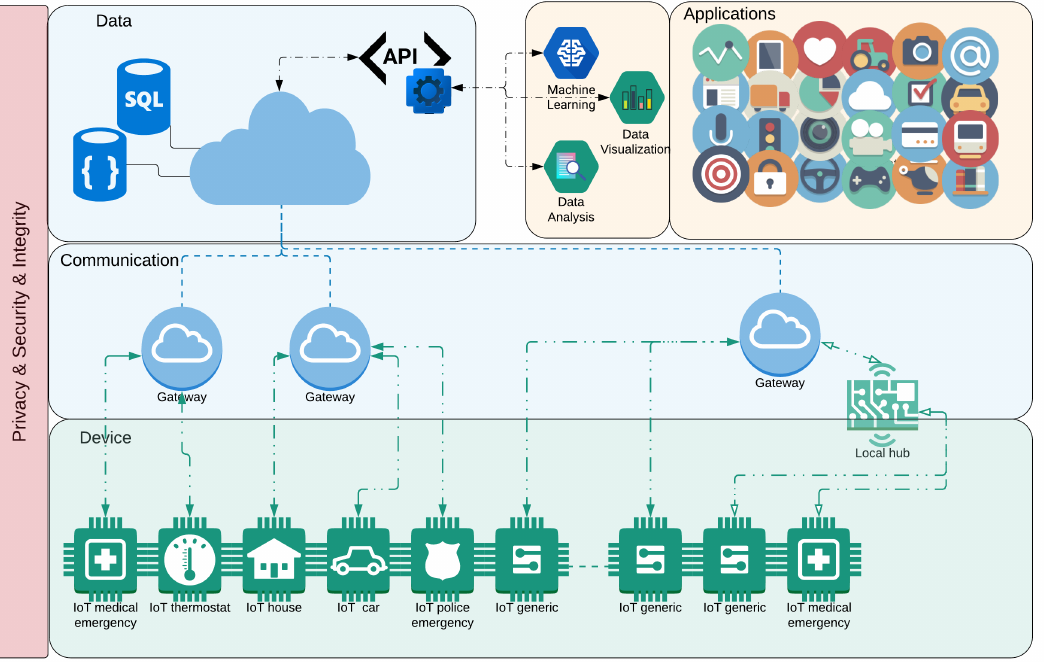
Figure 1. A Recommendation for a General Architecture for the pan-Canadian surveillance system proposed by UbiLab. This architecture is composed of the following main layers: (i) Device representing the different types of (IoT) devices that can be integrated into the system, (ii) Communication enabling the devices to communicate with the data sources on the Internet, (iii) Data representing and storing the information generated and collected by the devices, (iv) Applications representing the consumers/providers of information, and (v) Privacy and Security a cross-layer to contemplate the triad of confidentiality, integrity, and